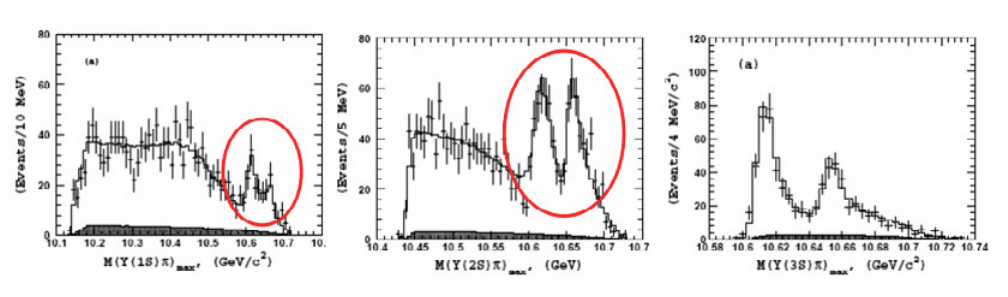
Figure 2. Invariant mass of the Υ ( n ) π systems, n = 1 , 2 , 3, Ref. [22].